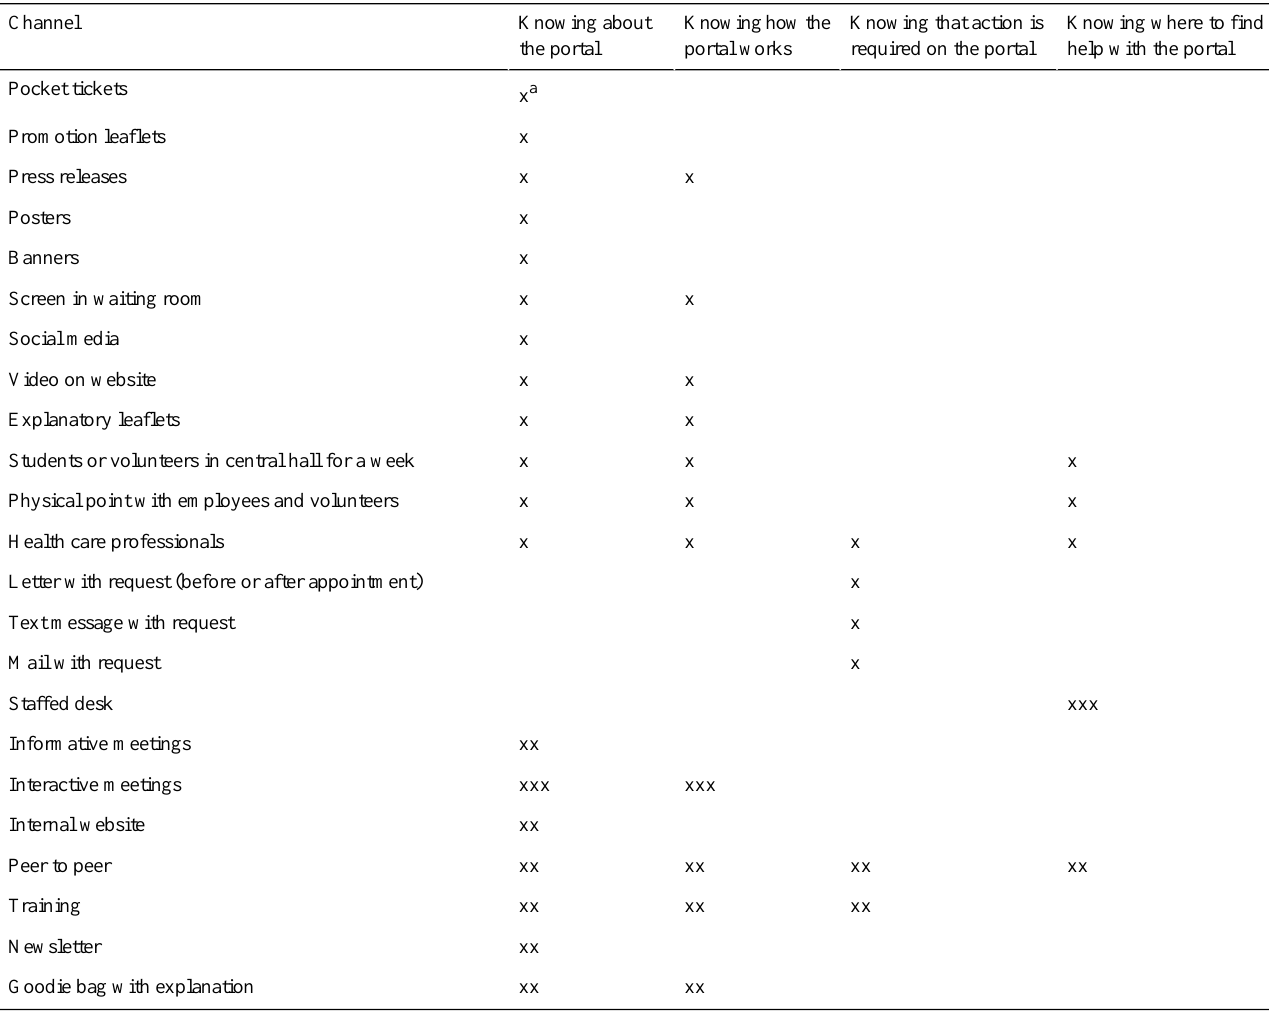
Knowing where to